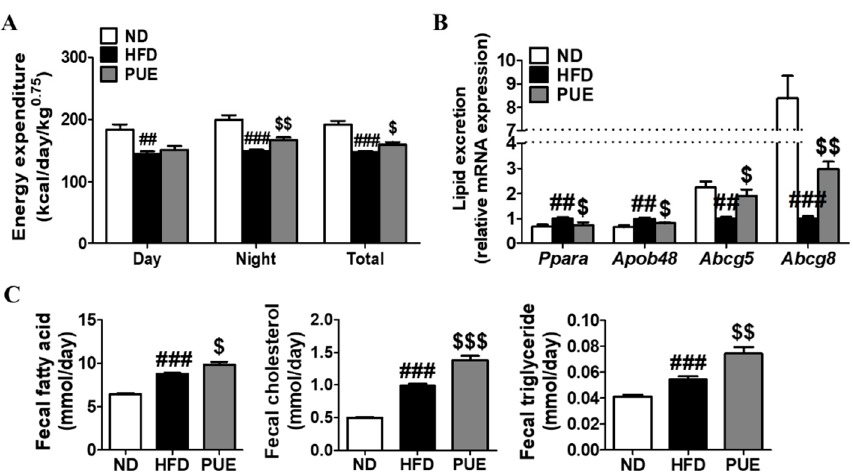
Figure 3. Effect of P. umbrosa root extract supplement on energy expenditure, small intestine gene expression related to lipid excretion, and fecal lipid content in DIO mice. ( A ) Energy expenditure; ( B ) Small intestine gene expression; ( C ) Fecal lipid contents. ( A – C ) Data are presented as means ± SEM.; ND, normal diet (AIN-93G); HFD, high-fat diet (60 kcal% fat); PUE, HFD + P. umbrosa root extract (1% w / w ). Significant differences between HFD and ND are indicated by ## p < 0.01; ### p < 0.001. Significant differences between HFD and PUE are indicated by $ p < 0.05; $$ p < 0.01; $$$ p < 0.001.